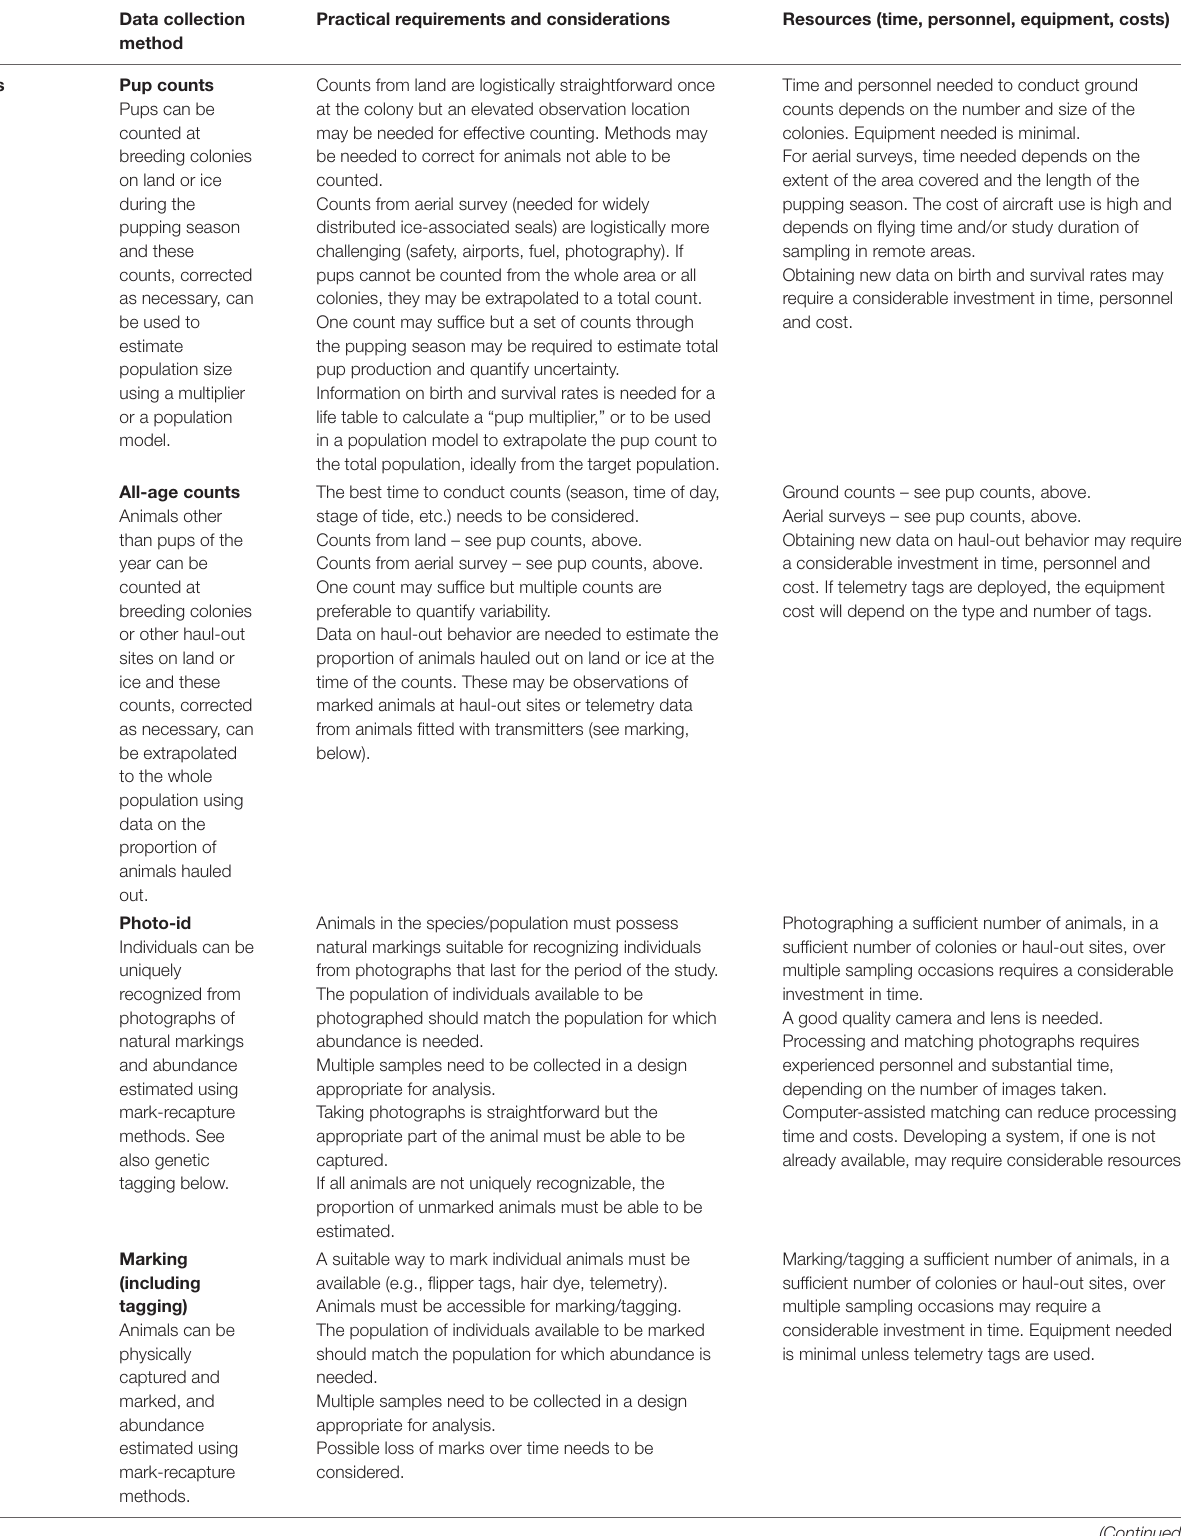
TABLE 3 | Summary of practical requirements and resource needs for obtaining data to estimate abundance of marine mammal